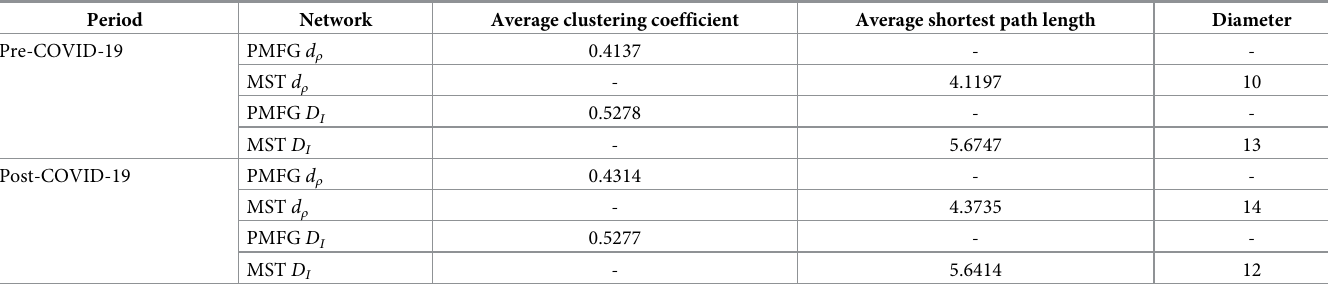
Table 2. Network comparison for PMFGs and MSTs based on correlation coefficient and mutual information.